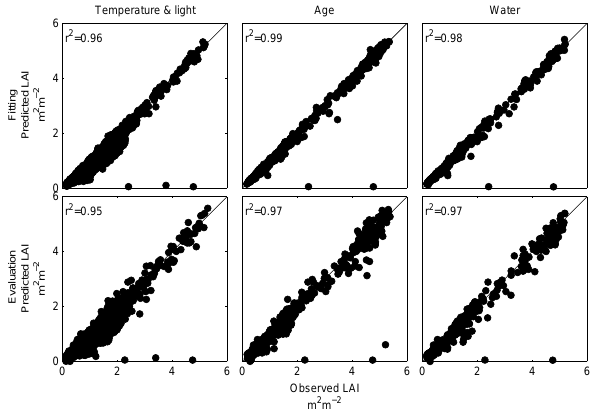
Fig. 6. Comparison of observed and predicted mean LAI for the fitting (top, 2001–2005) and evaluation (bottom, 2006) periods for the three limiting phenological regimes (Sect. 3.5).